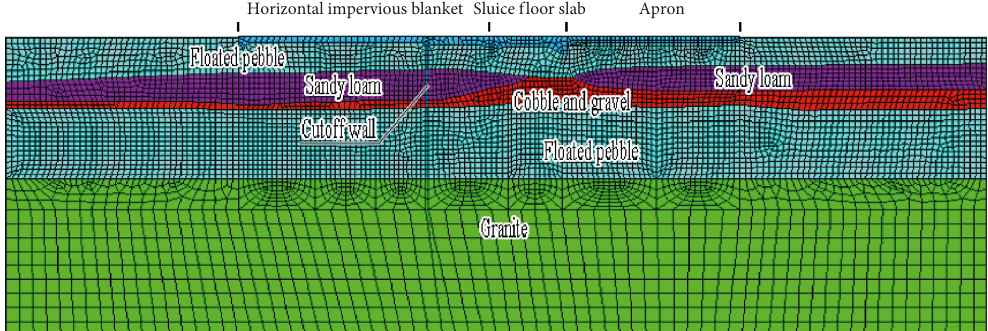
Figure 13: Finite element mesh for 1# sluice foundation.